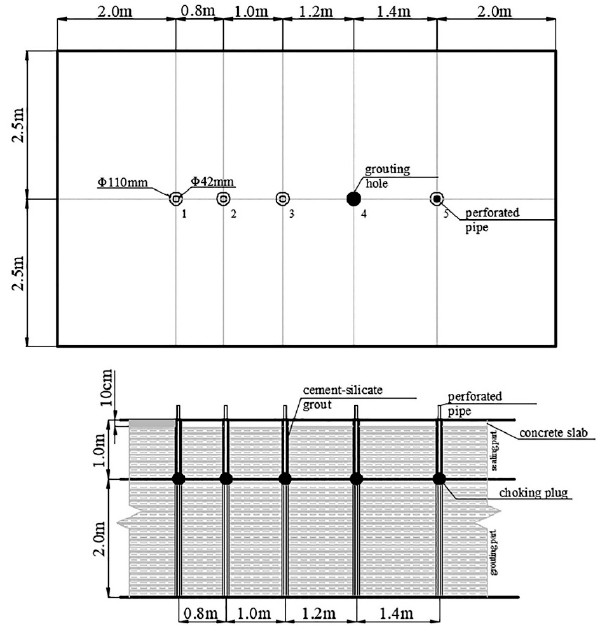
Figure 2. Layout of field test.